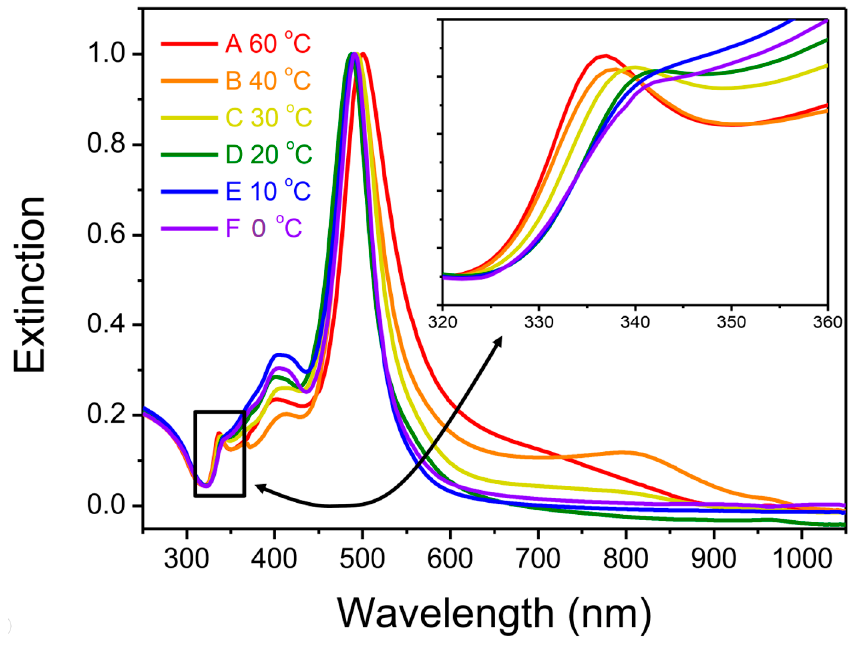
Figure 2. Extinction spectra of the product nanostructures synthesized at various temperatures: (A) 60 °C; (B) 40 °C; (C) 30 °C; (D) 20 °C; (E) 10; (F) 0 °C.